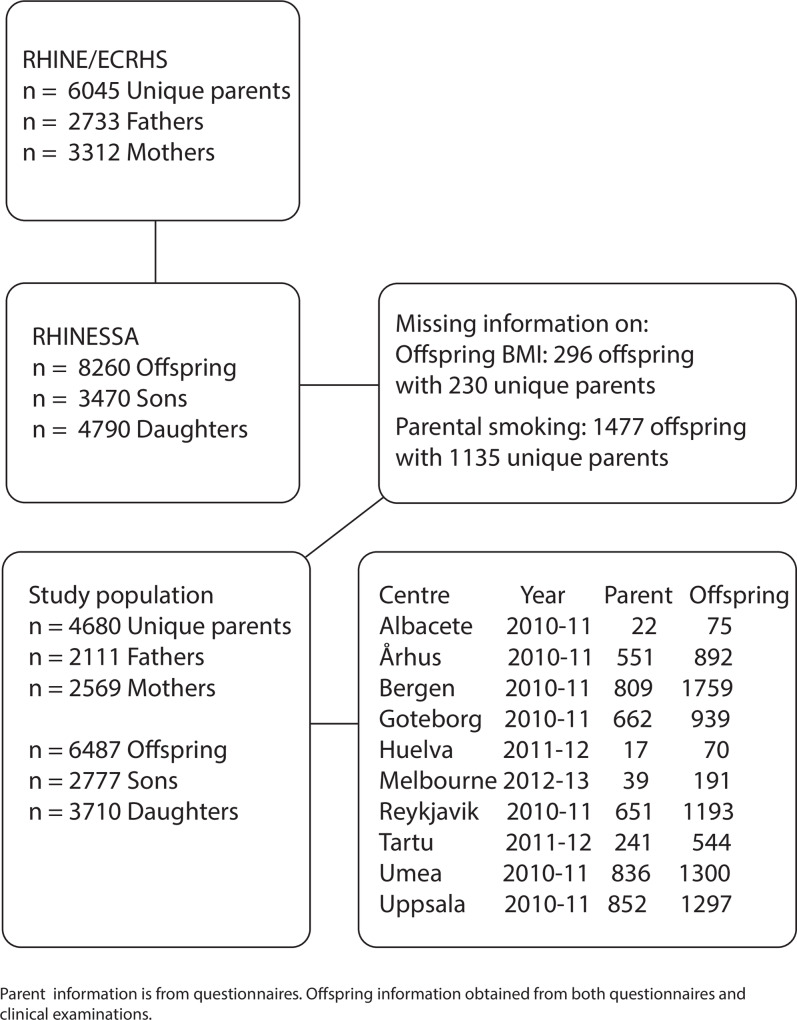
Flow chart of study population.Overview of eligible unique RHINE/ECRHS parents and their RHINESSA offspring, and number excluded due to missing information on offspring’s BMI and parental smoking habits.